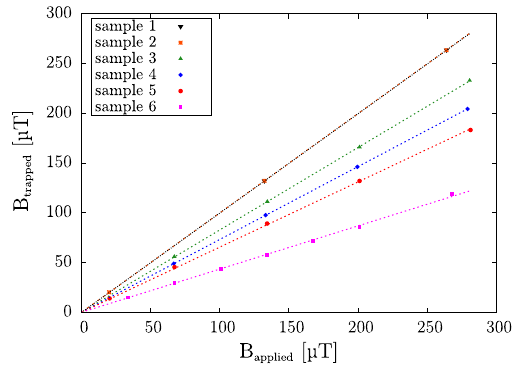
FIG. 5. Dependency of the trapped field on the applied field for all measured samples: None of the samples exhibited a dependency on the applied field. The data for samples 1 and 2 overlap—they both trap 100% of the applied field.